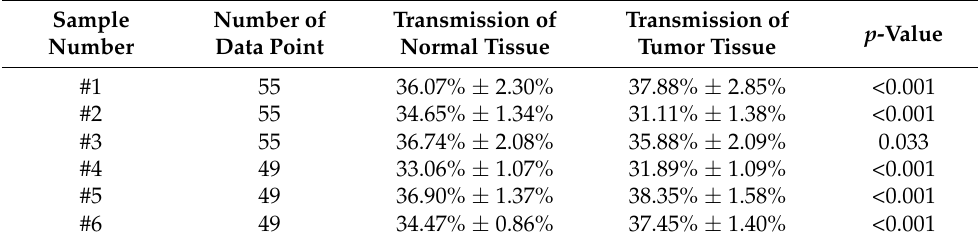
Table 1. Measured transmissions of the normal tissue and the tumor tissue for each sample. Data are presented as means ± standard